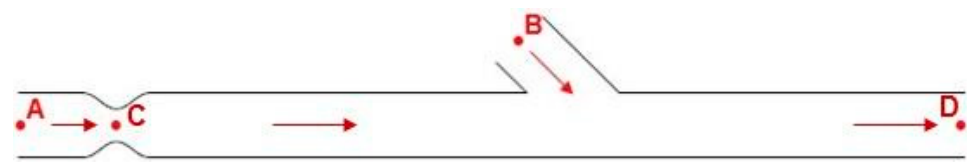
Figure 7. Area points of